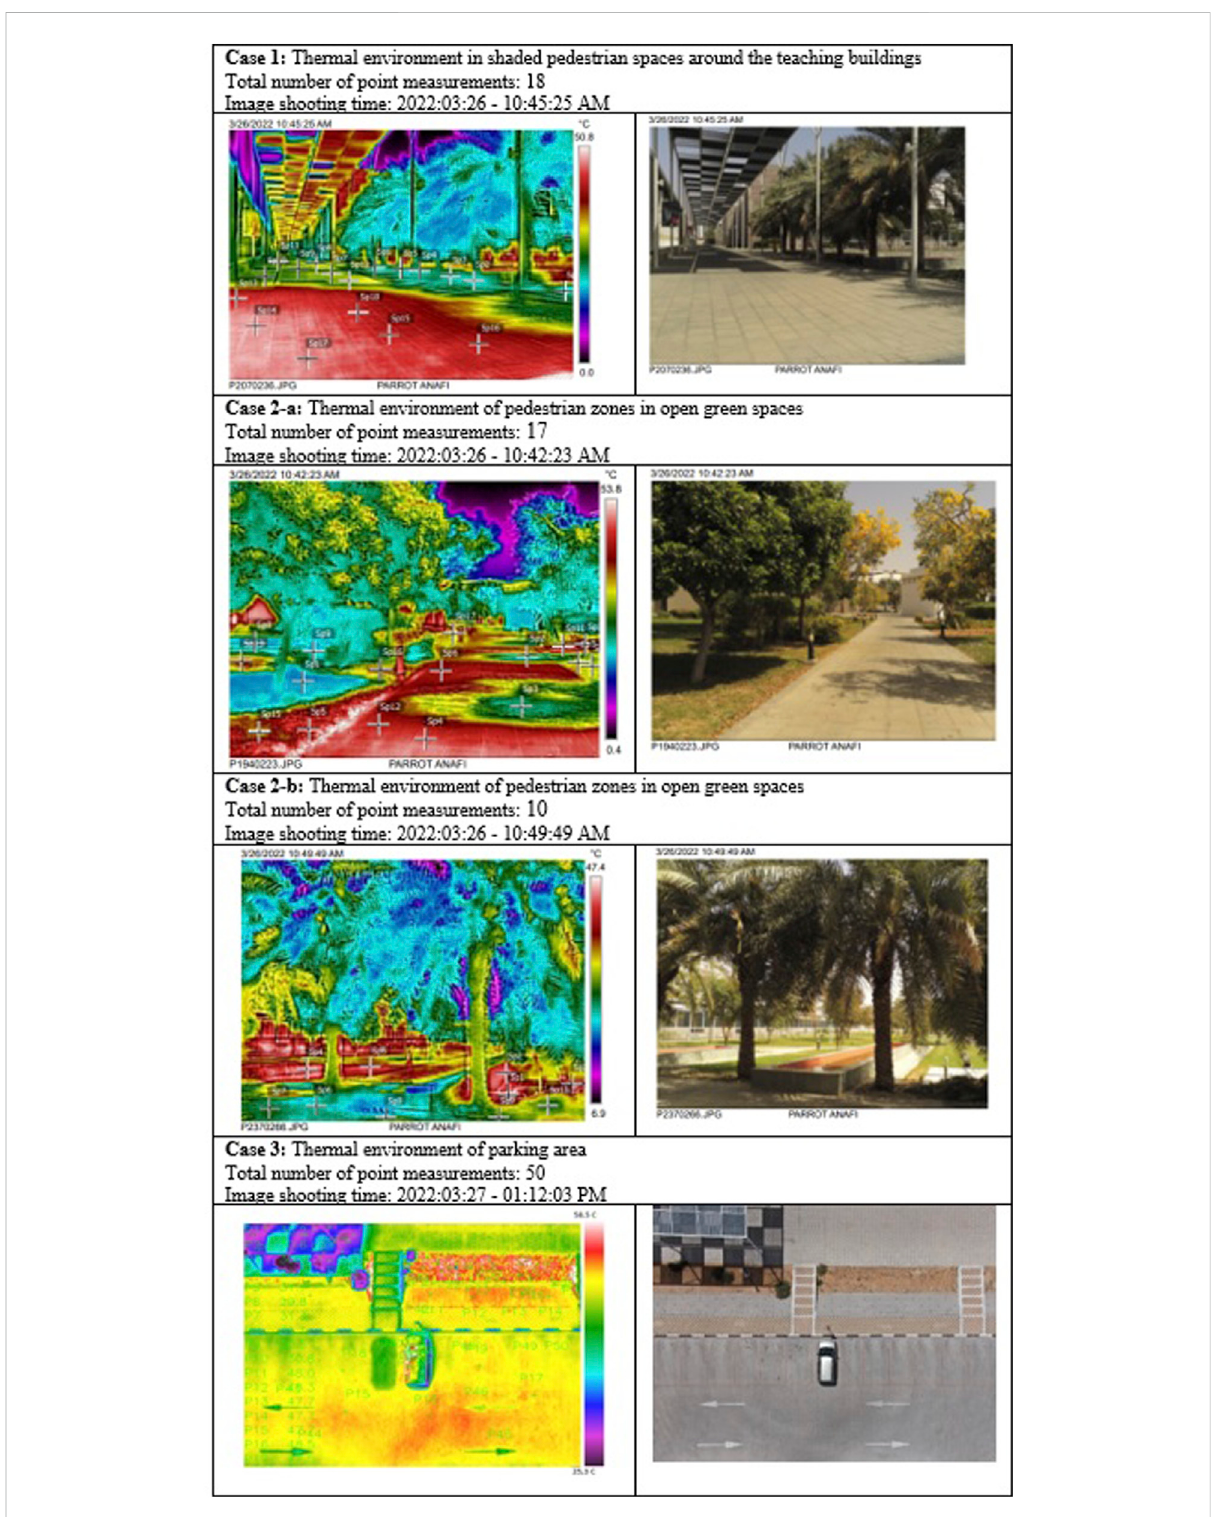
FIGURE 7 Thermal environment analysis in shaded pedestrian areas (Case 1), pedestrian zones in open green spaces (Case 2-a, Case 2-b), and campus parking